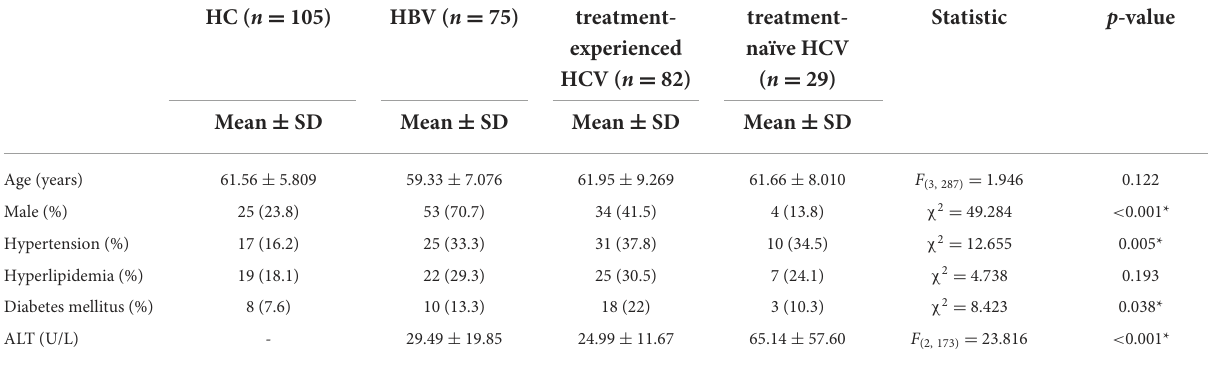
TABLE 1 Demographic and clinical characteristics of the study